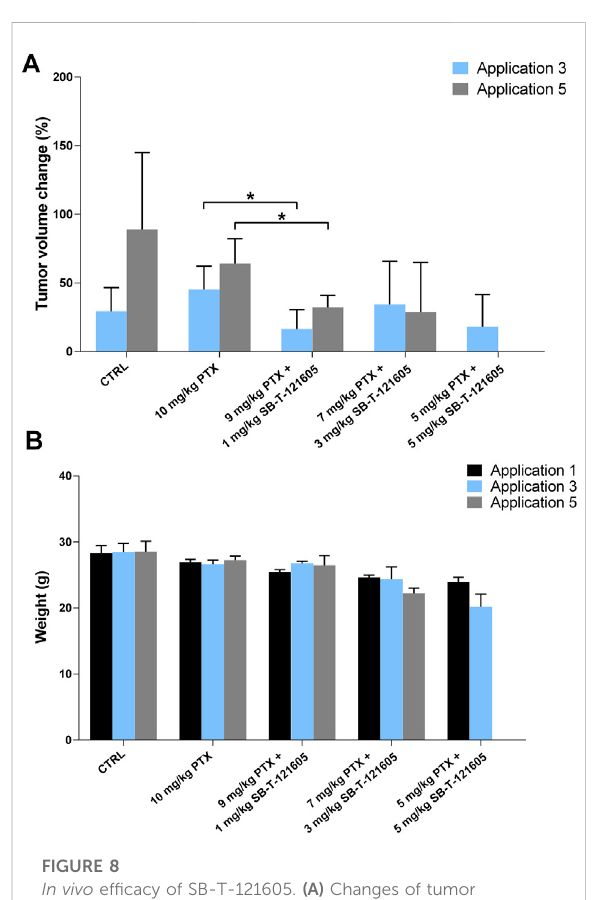
FIGURE 9 Comparison of in vivo ef fi cacy of SB-T-121605 and SB-T- 121606 administered alone in concentrations of 1 mg/kg and 3 mg/kg. (A) Comparison of proportional (%) change of tumor volume during experiment. (B) Changes of mouse weight (g) during the application in all examined experimental groups. * p -values by two-tailed Student ’ s t-test (* p ≤